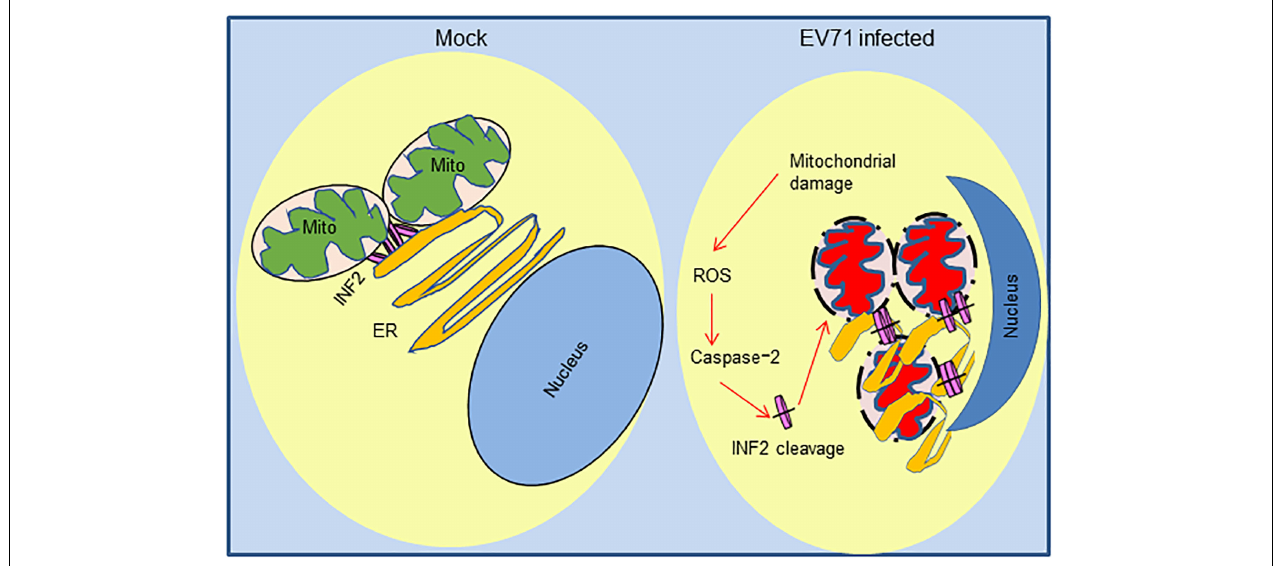
FIGURE 8 | Positive feedback regulatory mechanism of caspase-2 mediated INF2 cleavage in EV71-induced mitochondrial damage. In normal cells, INF2 is located at the ER and regulates mitochondrial dynamics; In EV71-infected cells, mitochondrial and ER are damaged, and ROS of mitochondrial source activate caspase-2, which cleaves INF2 and exacerbates mitochondrial damage in